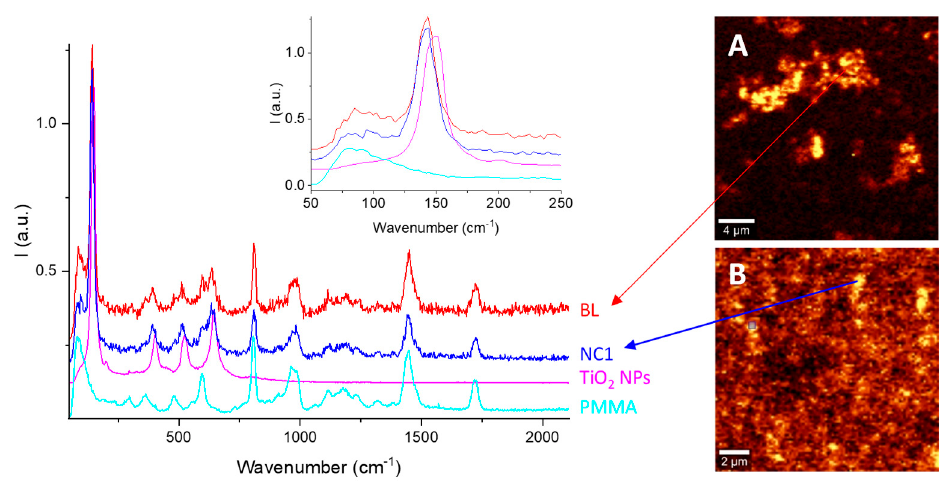
Figure 3. Raman spectra of PMMA (cyan), TiO 2 NPs powder (magenta), NC1 (blue), BL (red), and Raman imaging map of NC1 thin film ( A , 10 × 10 μ m) and BL thin film ( B , 20 × 20 μ m). Brighter spots indicate TiO 2 NPs Raman scattering at 141 cm − 1 . Inset: focus on the region of the E g (1) vibration mode.